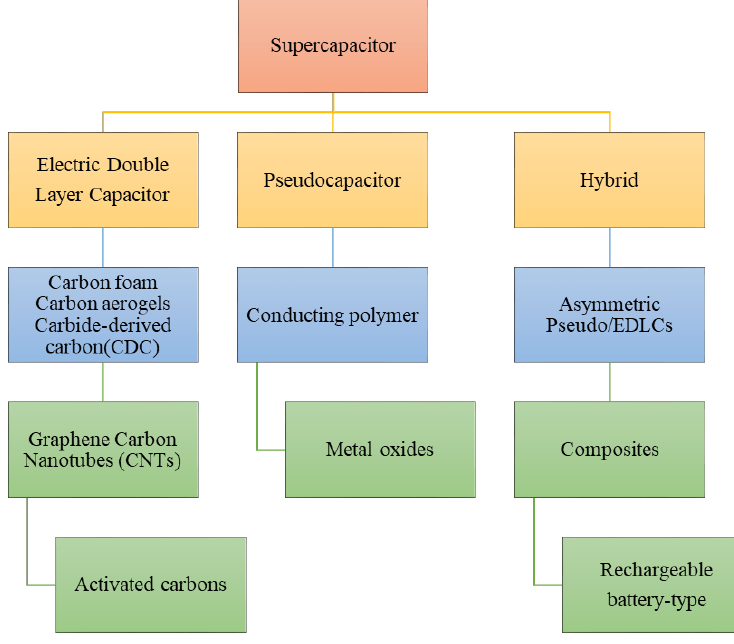
Figure 1. Types of supercapacitors.